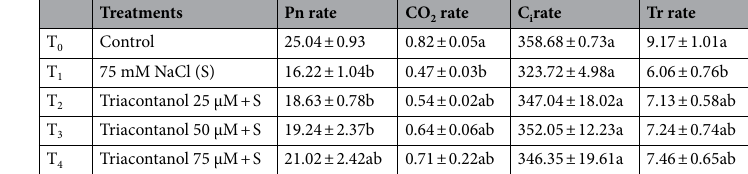
Table 2. Effects of triacontanol spray on gas exchange attributes of Hot pepper plants under salt stress. Means sharing the same letter for a parameter, do not differ significantly at p ≤ 0.05; Pn = photosynthesis rate; Tr = transpiration rate; Ci = internal CO 2